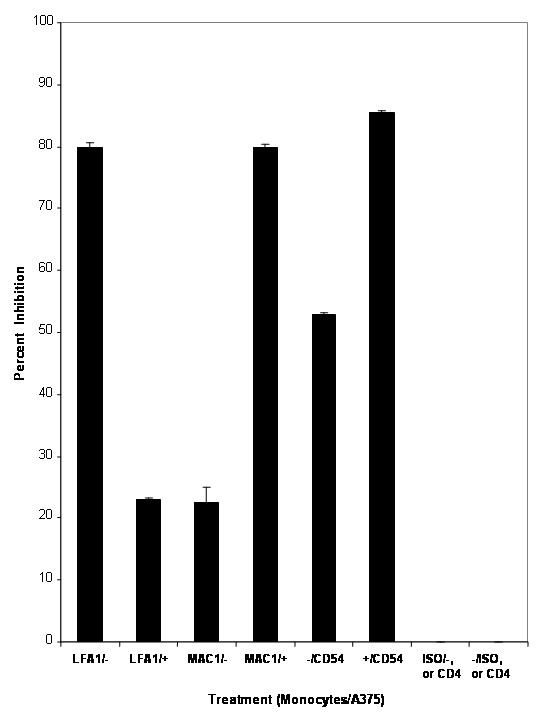
Effect of monoclonal anti-αLβ2, -αMβ2 and CD54 on monocyte adherence to tumor cells under flow conditions in the presence or absence of sFn. Anti-αLβ2 inhibited monocyte adherence to untreated cells (P <0.05; n = 3), but was significantly (P < 0.01 compared to non-sFn treated cells; n = 3) less effective in blocking monocyte binding to sFn pre-treated tumor cells. Conversely, anti-αMβ2 inhibited monocyte adherence to sFn pre-treated tumor cells to a significantly (P < 0.01) greater extent than to untreated tumor cells. Anti-CD54 inhibited monocyte adherence to untreated tumor cells by over 50%, and by over 80% when tumor cells were pre-incubated with sFn. Isotypic control IgGs or an irrelevant monoclonal antibody (CD4) did not affect monocyte adherence.